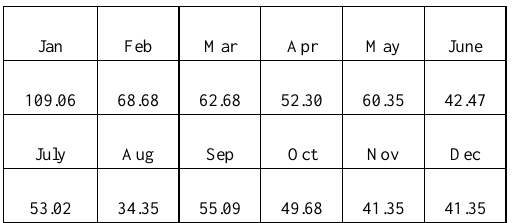
Table 4.Forecasts for the 17th to the 20th of January